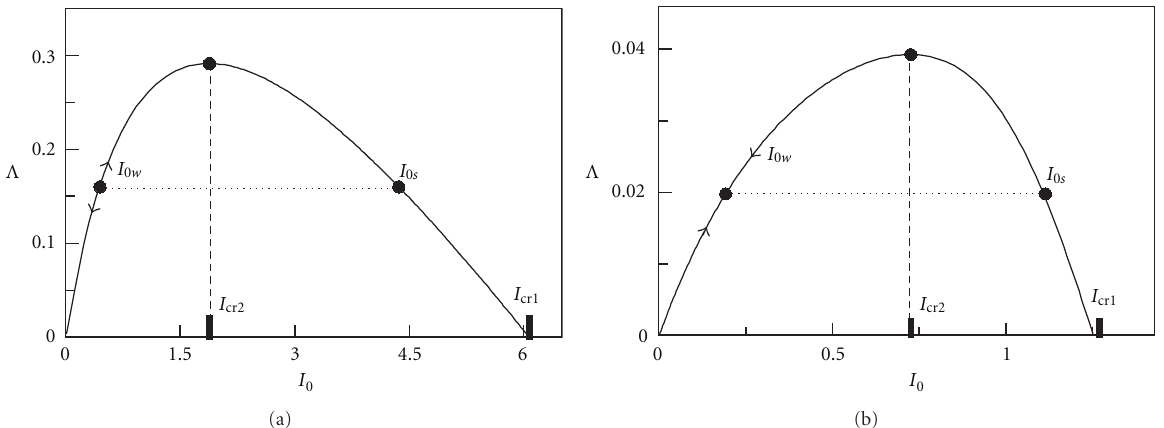
Figure 9: Dependences of the nonlinear-dispersion part of amplification Λ for intracavity pulses on their peak intensity I 0 for hard (a) and soft (b) regimes of excitation and annihilation of the second